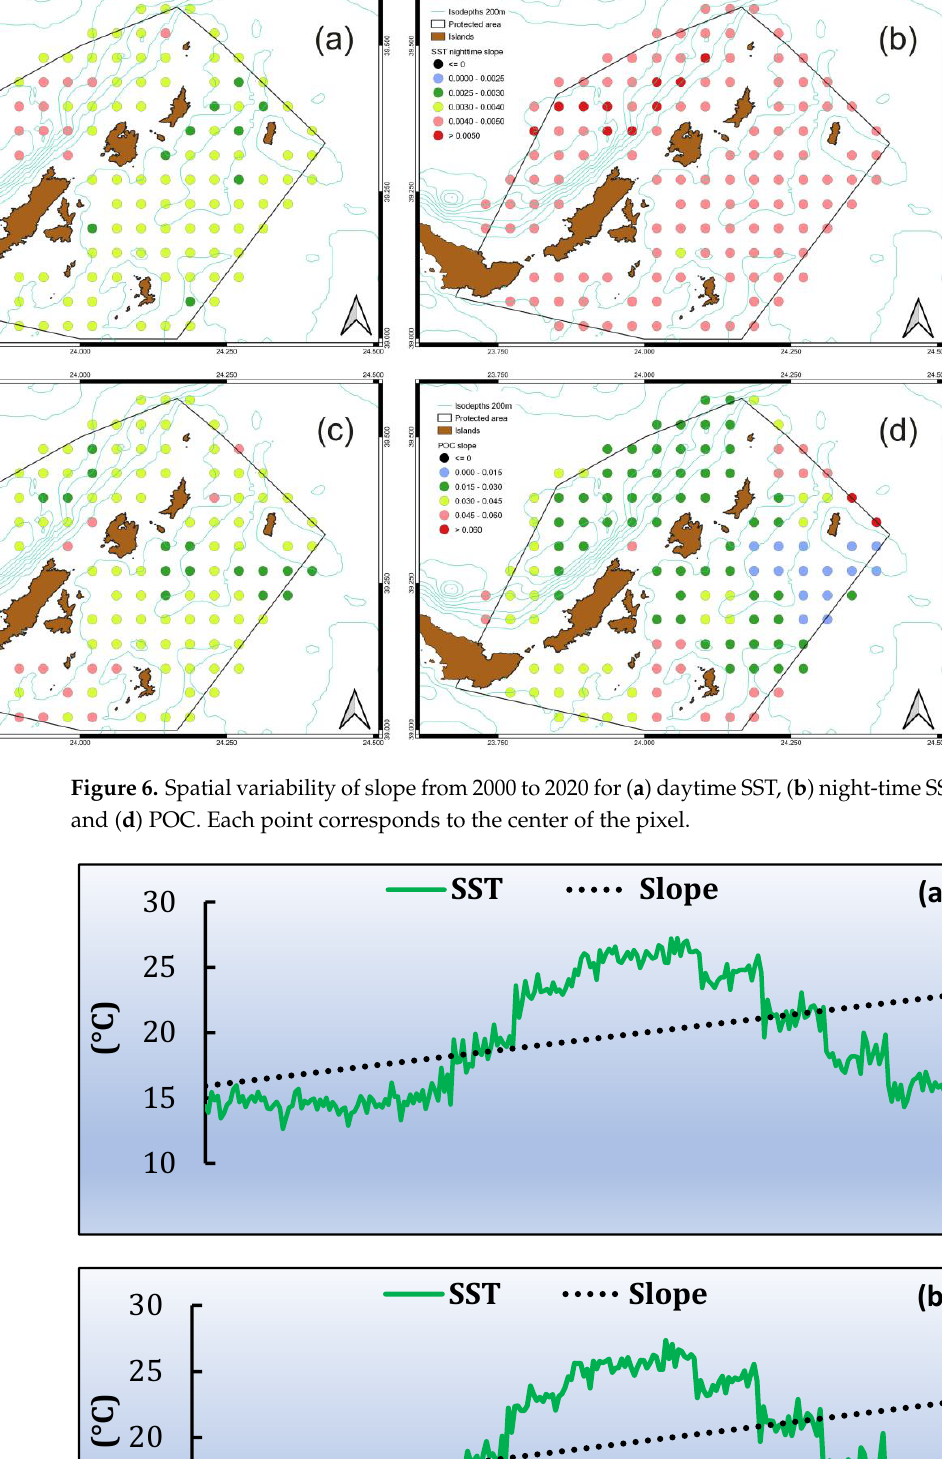
Remote Sens. 2022 , 14 , x FOR PEER REVIEW